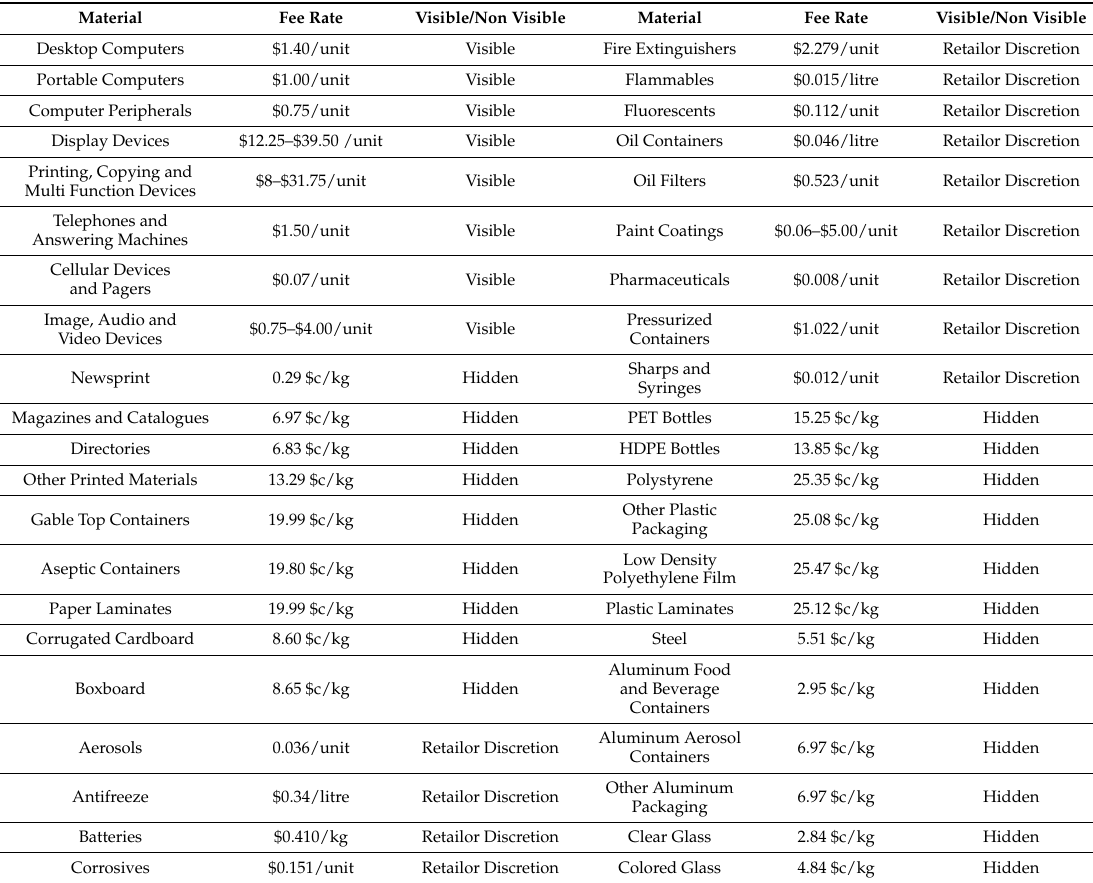
Table 2. Ontario’s Fee Schedule for the Residential Waste Stream (Adapted from Stewardship Ontario (2015) [17] and Ontario Electronic Stewardship (2015)